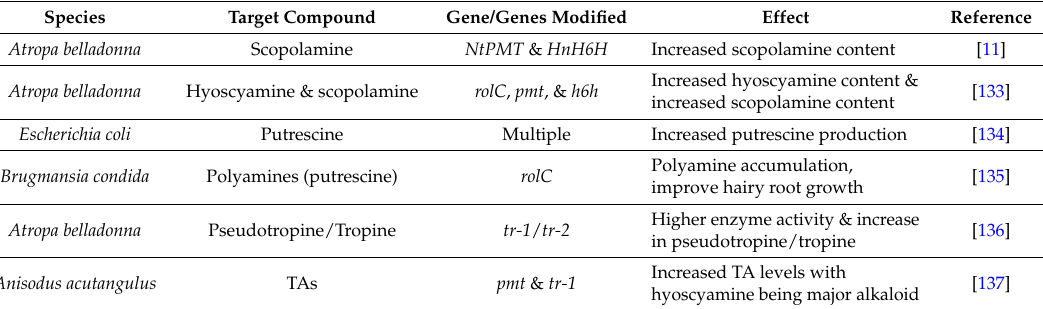
Table 2. A summary of recent metabolic engineering studies targeting specific